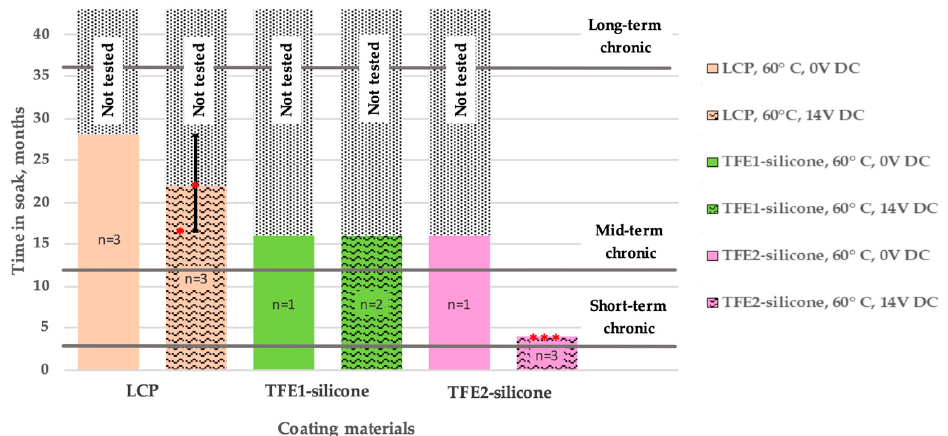
Figure 5. Lifetime of different coatings on LCP substrates with Au IDCs in 60 °C PBS. End of a sample’s lifetime was indicated by a >10% deviation of the impedance magnitude at 0.1 Hz, compared to the original value at the beginning of the aging study. Red asterisks (*) represent failed samples at the corresponding month.